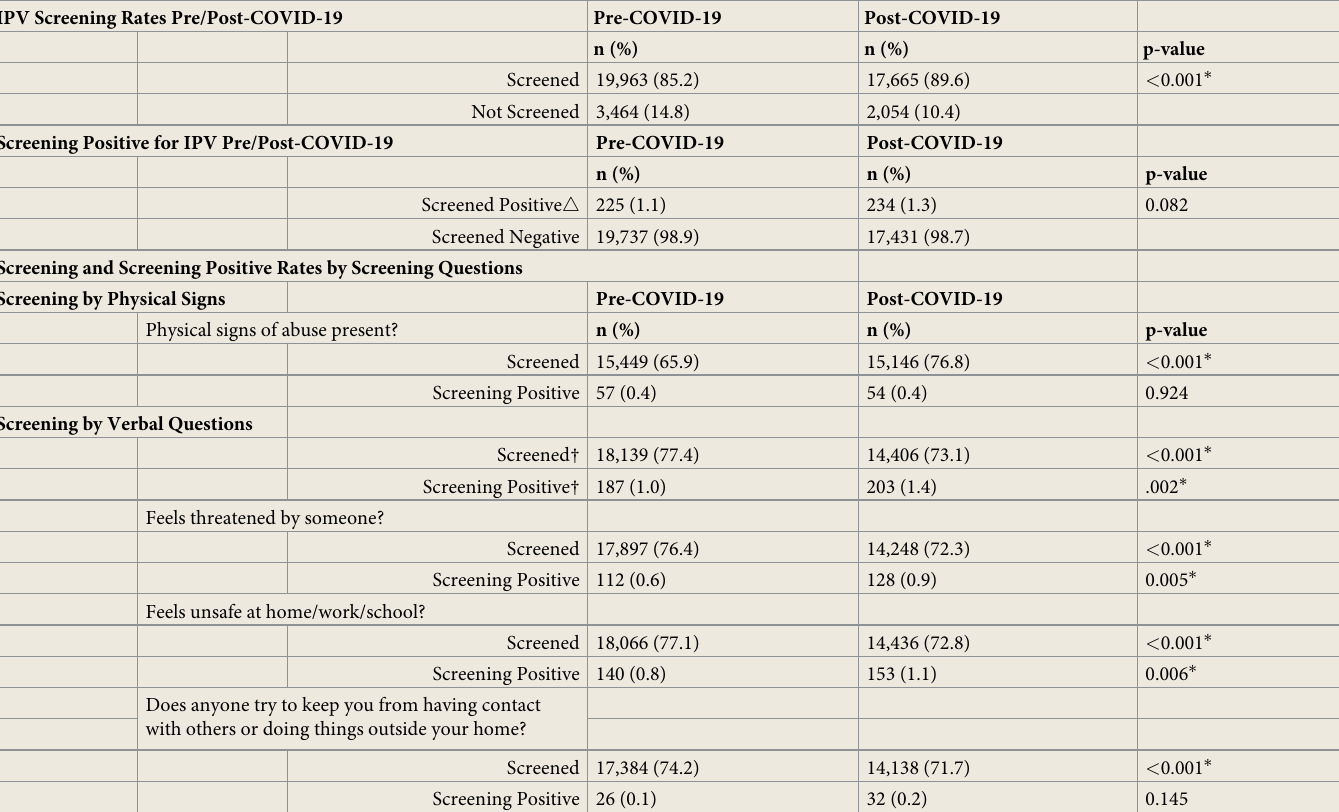
Table 2. Bivariate analysis of IPV screening and IPV screening positive pre- and post-COVID-19. IPV Screening Rates